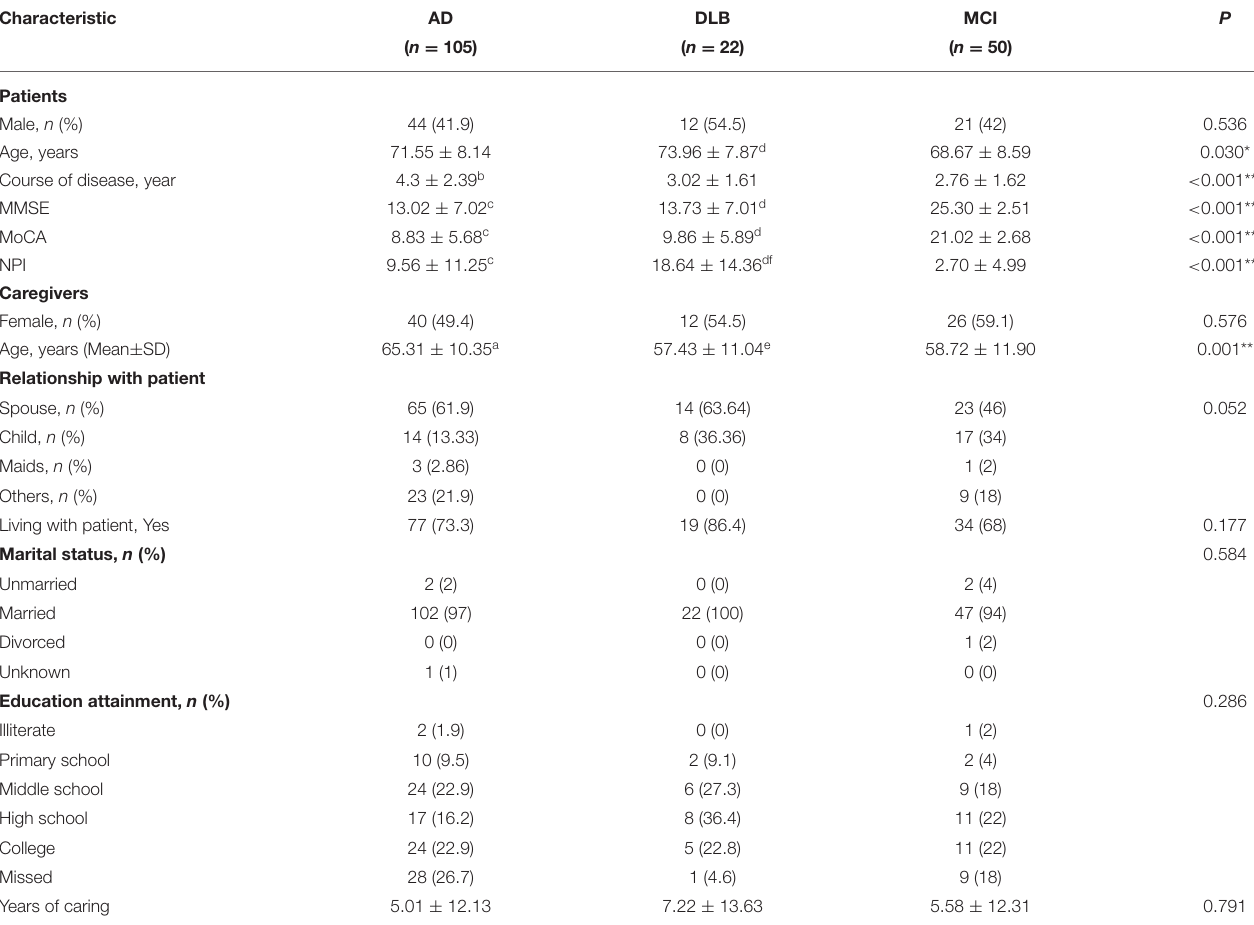
TABLE 1 | Baseline characteristics of the AD, DLB and MCI patients and their caregivers. Characteristic AD DLB MCI